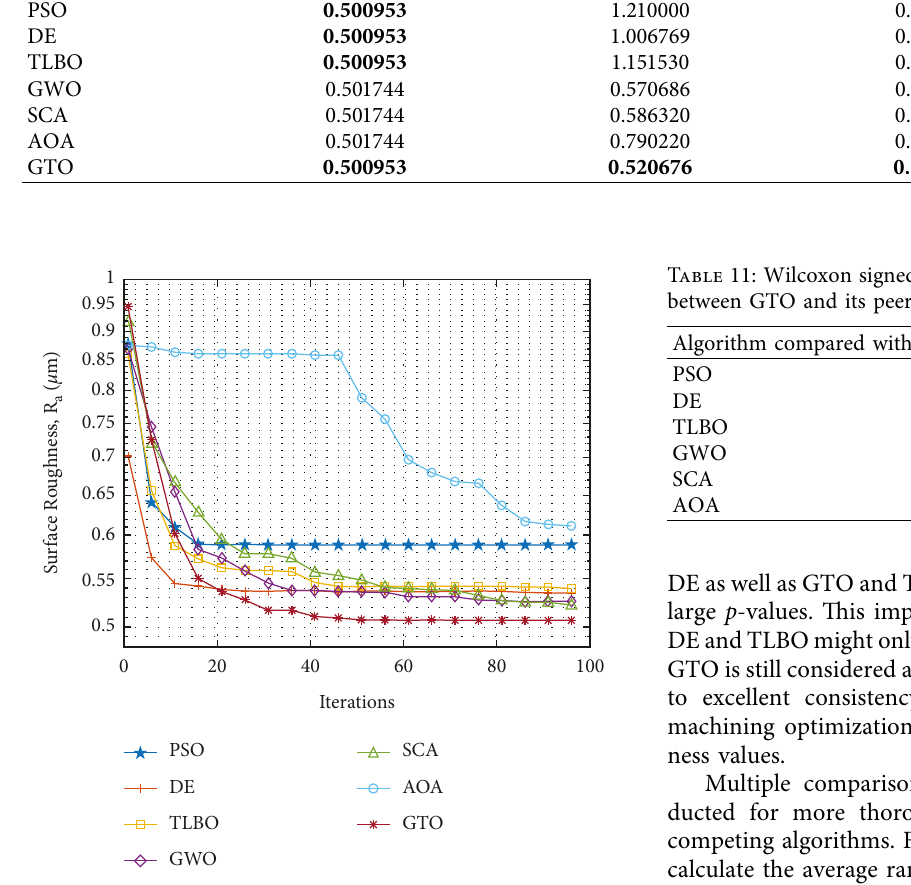
Table 10: The best, worst, mean, and standard deviation ( SD ) values of surface roughness produced by all compared algorithms. Algorithm